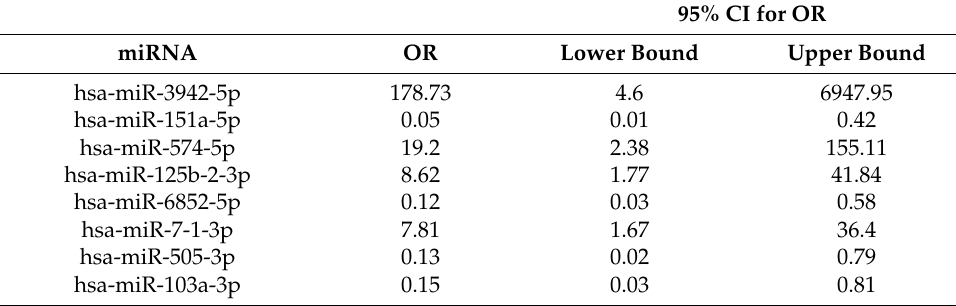
Table 2. Significant miRNAs by the Vitamin D Treatment Arm Interaction in